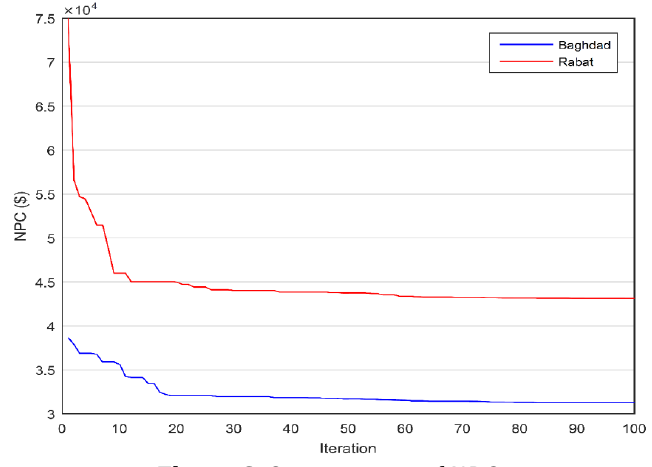
Figure 6. Convergence of NPC Table 5 . Diesel parameters